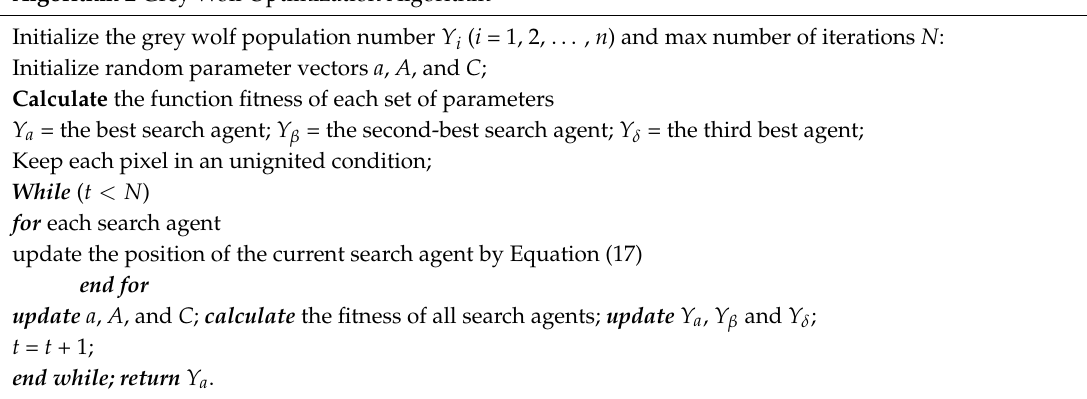
Algorithm 2 Grey Wolf Optimization